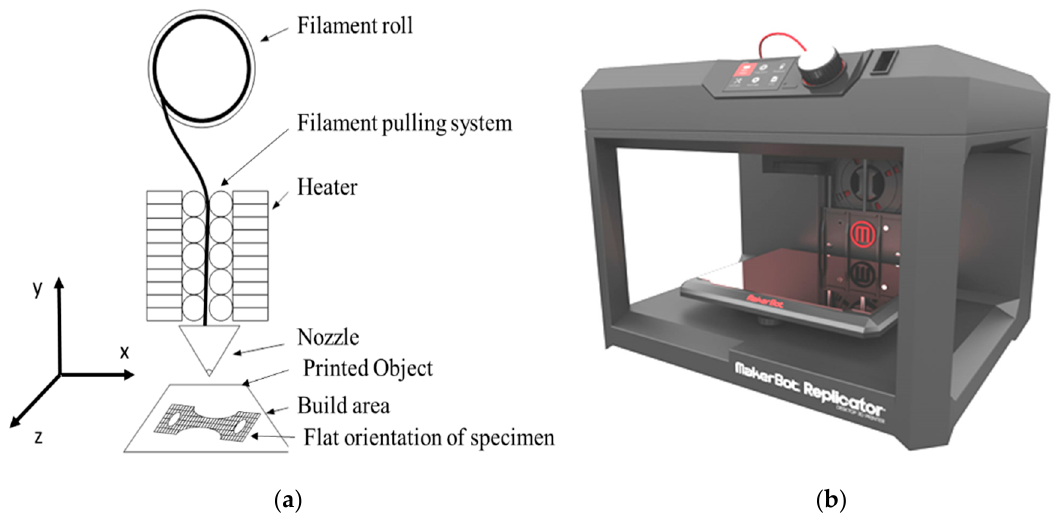
Figure 1. ( a ) Schematic of fused deposition modeling. ( b ) Actual 3D printing setup of fused deposition modeling (FDM).